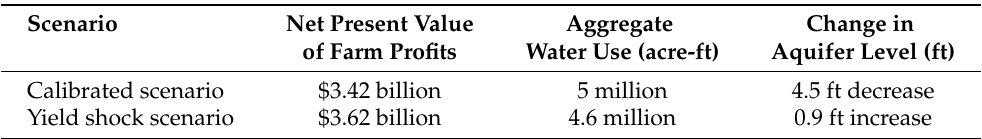
Table 4. Farmer welfare, aggregate water use, and localized changes in groundwater levels (over 20